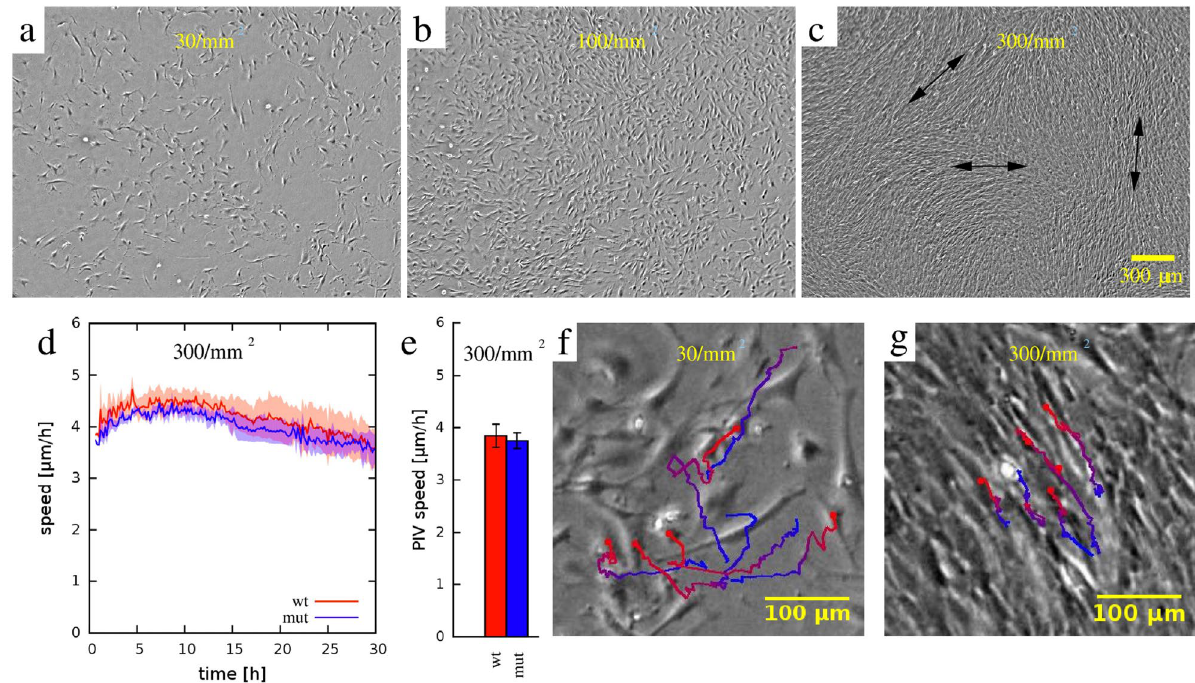
Figure 5. Primary MEPM cells show directional alignment at high density in 2D random motility assays. ( a – c ) Representative phase contrast micrographs of wildtype (WT) MEPM cells at low (30/mm 2 ), medium (100/ mm 2 ), and high (300/mm 2 ) plating densities. When cultured at high cell densities, MEPM cells exhibited a local directional alignment of cells (arrows). ( d ) The average cell motility speed of high density MEPM cultures demonstrated sustained cell motility despite the high cell density. Velocities were calculated by PIV analysis and averaged over the entire field of view. Orange and blue colors indicate WT and Specc1l -mutant cells, respectively. Solid lines are averages of 4 independent fields, shaded areas indicate SEM. ( e ) The average speed of both WT and mutant cells were calculated for the entire recorded time period. Error bars indicate SEM, the difference is not significant. ( f , g ) Tracks of individual cells in low ( f ) and high density ( g ) cultures. The random and uncorrelated motility at low cell densities ( f ) became highly aligned at high densities evidenced by the parallel trajectories ( g ). Trajectories are plotted for a time period of 8 h, with red and blue colors indicating earlier and later segments,